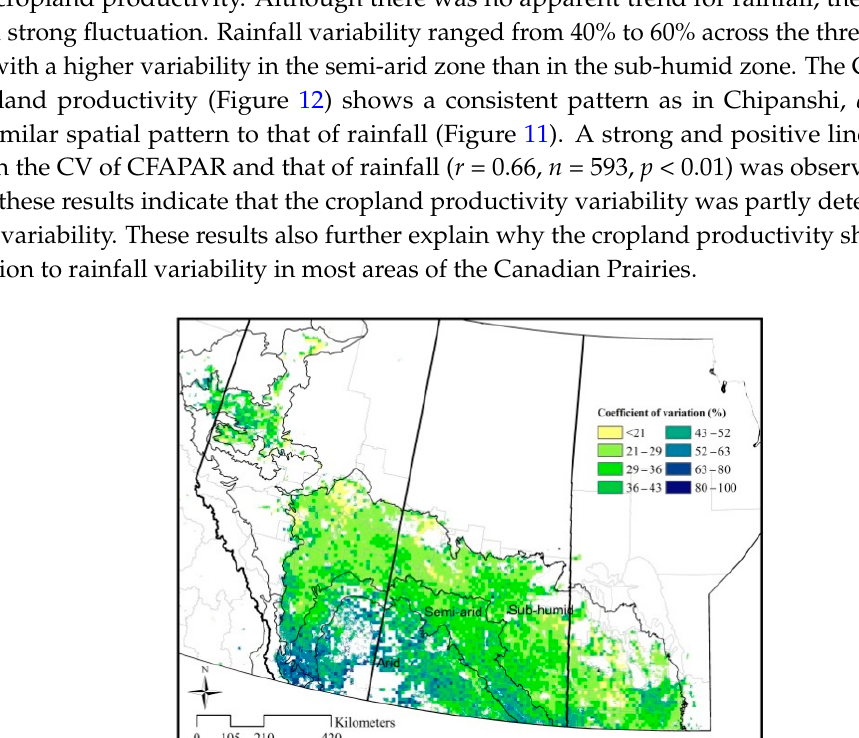
Figure 11. The coefficient of variation (CV) about the temporal variability of annual cumulative rainfall during the period of 2000–2013.